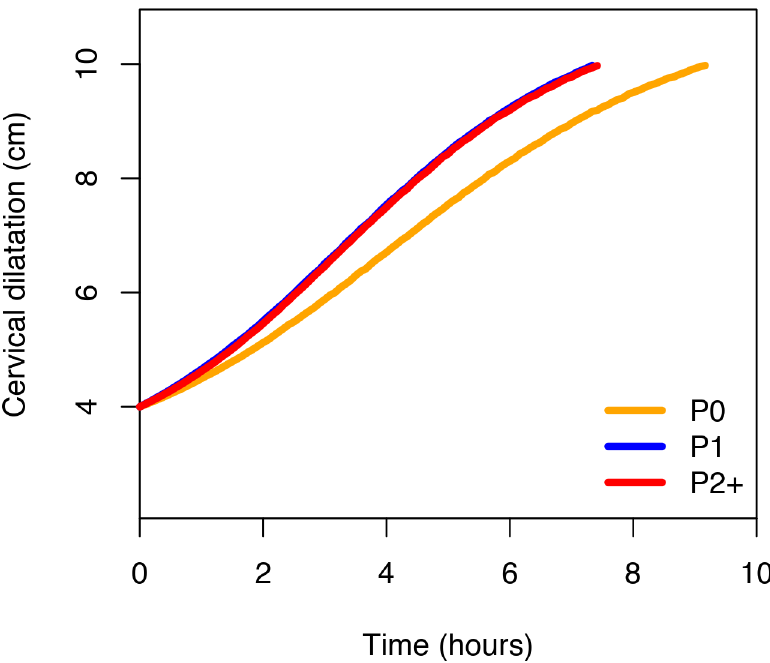
Fig 6. Average labour curves by parity after excluding women with augmented labours. P0, nulliparous women; P1, parity = 1 women; P2+, parity = 2+ women.